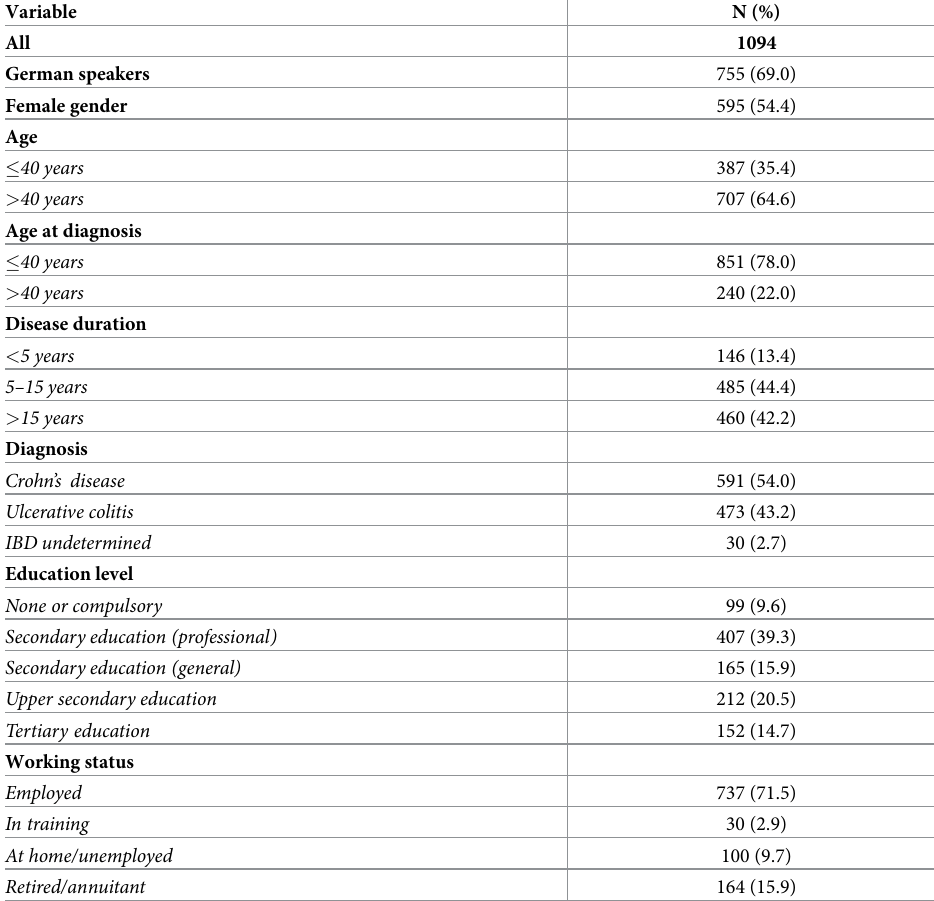
Table 1. Baseline characteristics of patients included in the cross-sectional